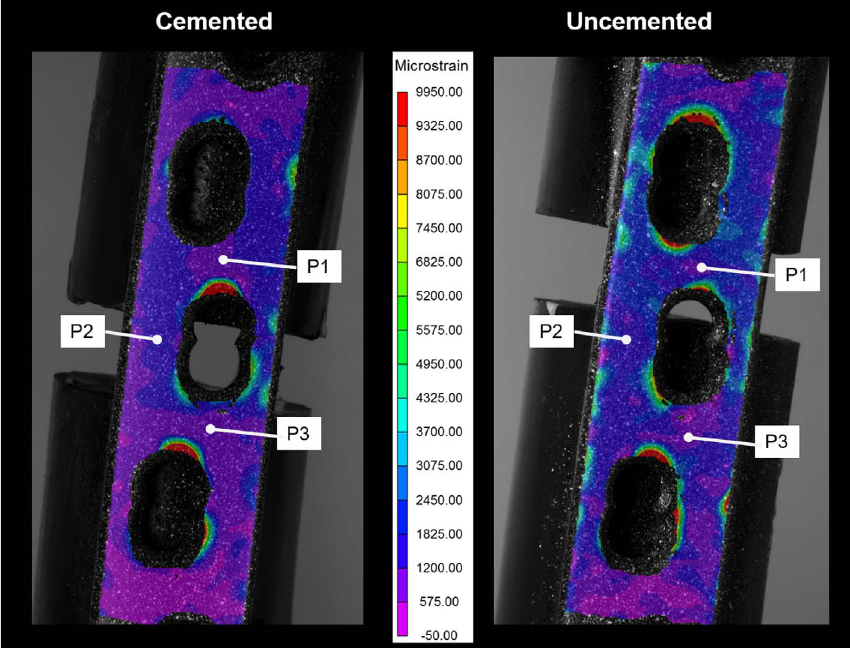
Figure 5. Comparison between the pattern of maximum principal strain across the fracture plate at site of fracture, between the uncemented and cemented group at 500 N axial load.